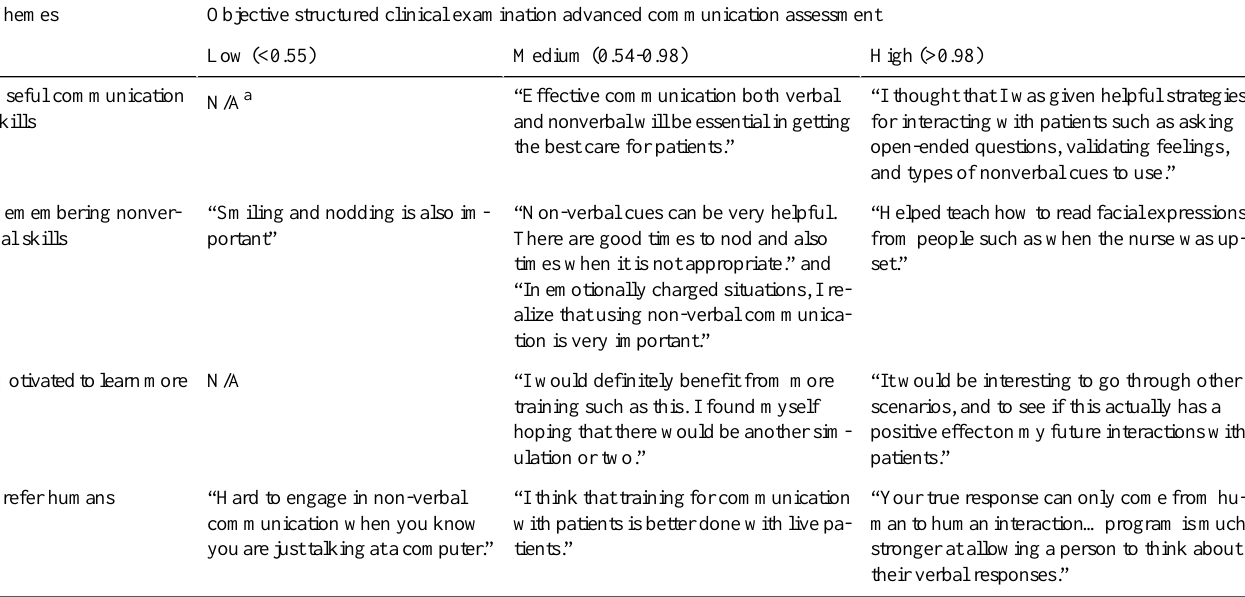
Table 1. A joint display of qualitative themes by quantitative performance level on an objective structured clinical examination. Objective structured clinical examination advanced communication